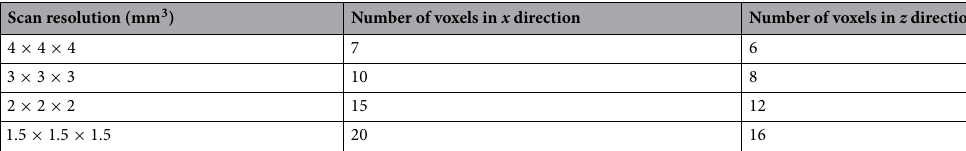
Table 2. The number of voxels used in the x and z directions for the four spatial resolutions to delineate a slice in the axial plane in the mid-ascending aorta.